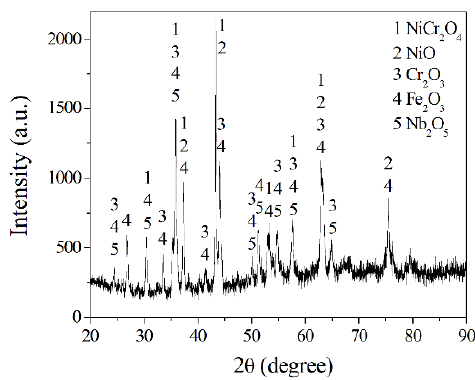
Figure 8. XRD patterns of the GH4169 substrate after high temperature oxidation at 1100 °C for 110 h.